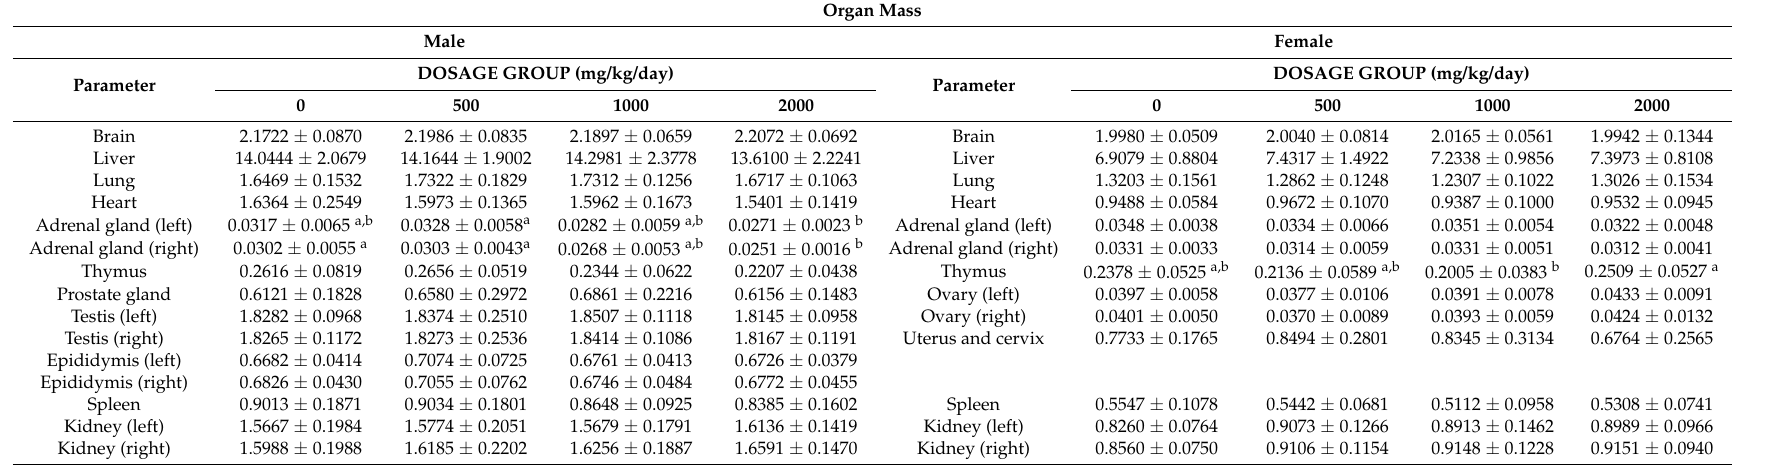
Table 8. Organ masses (g) of male and female rats given 500, 1000, or 2000 mg/kg/day GEE for 13 weeks in a repeated oral dose toxicity